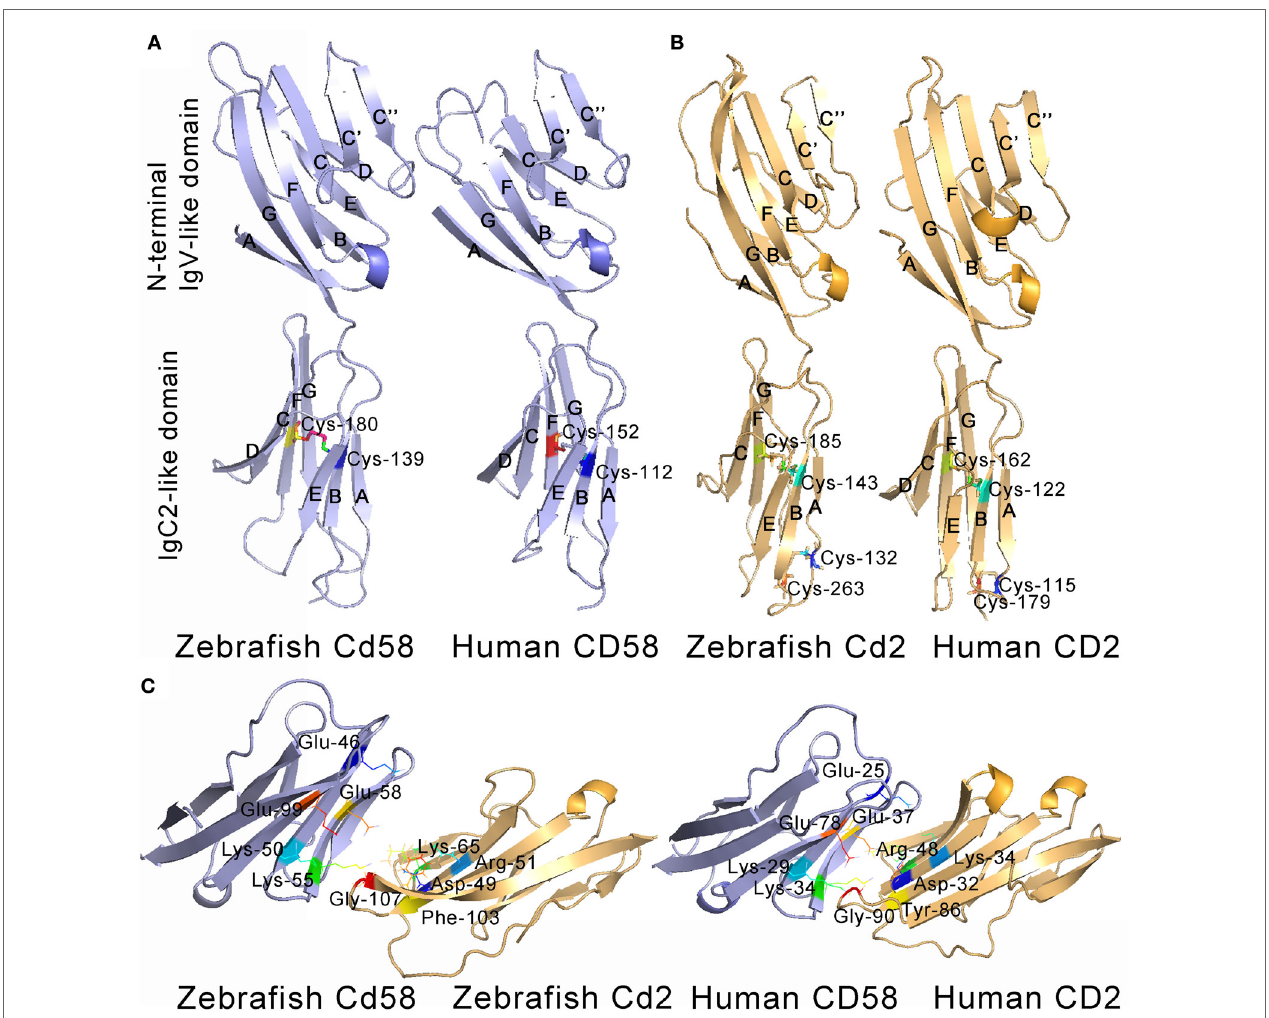
FigUre 2 | Tertiary structures of the extracellular domains of CD58 (a) and CD2 (B) . The structures were predicted by homology modeling with human CD58 (PDB 1CCZ) and CD2 (PDB 1HNF) extracellular domains as templates, showing the overall homology with human counterparts. The β strands of N-terminal IgV-like domains (AGFCC ′ C ″ BED) and the membrane-proximal IgC2-like domains (AEBDCFG and AEBCFG) of CD58 (blue) and CD2 (yellow) are labeled. (c) Detailed views of anti-parallel β -strands in stacked pleated β -sheets, α -helix structures, hydrophobic loops, Cys residues, and residues across the CD2–CD58 interface are depicted and